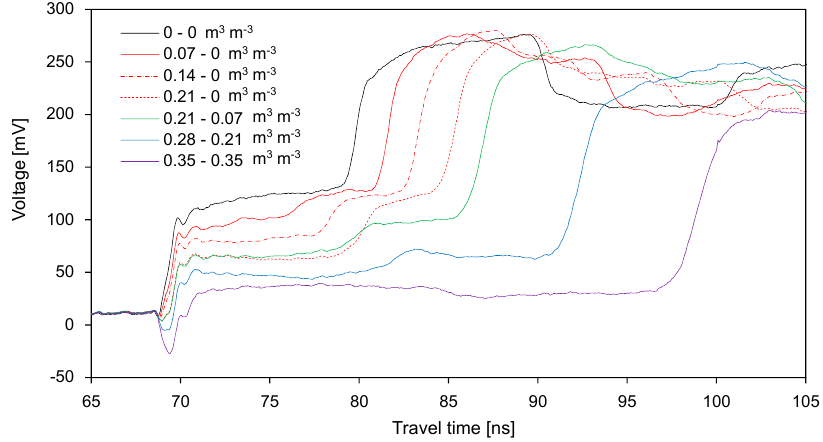
Figure 8. Variance of the signals with the SWC in the wet-dry treatment.